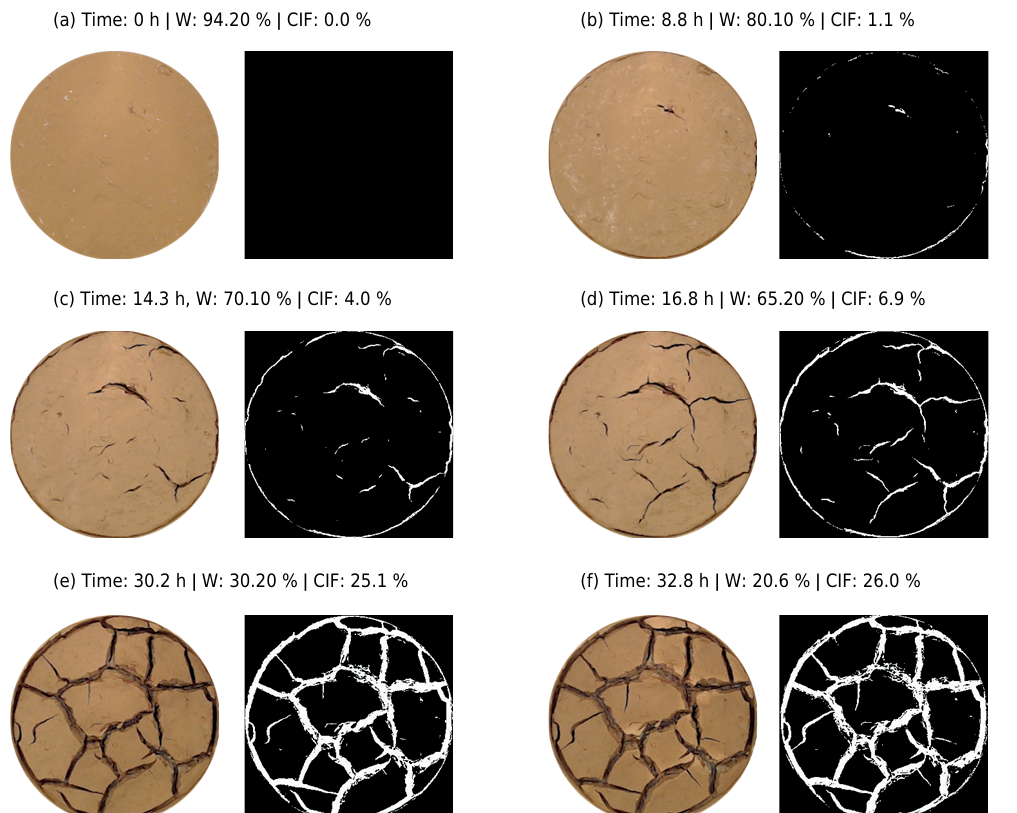
Figure 4. Process of crack development: Test 2 – W i = 94.20